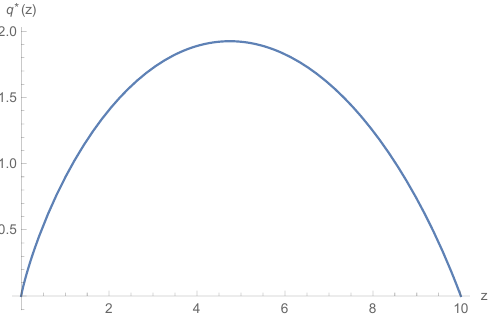
Figure 2. The optimal reinsurance policy with respect to z at time t = 1.